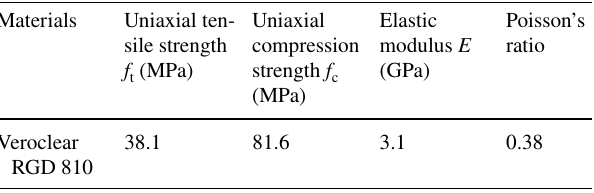
Table 1 Mechanical parameters of the printing material at room tem-